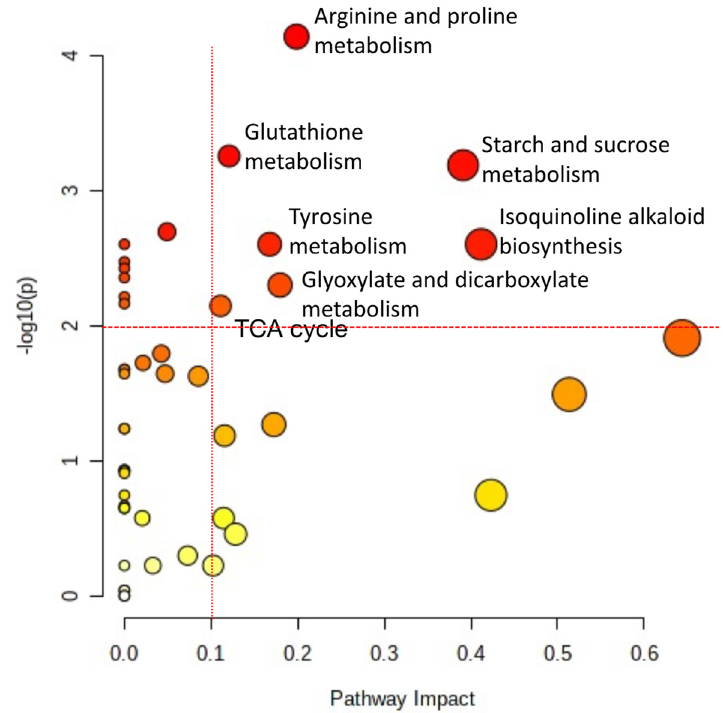
Figure 7. Significantly changed lettuce metabolism after 3 days of water, 1% and 2% horseradish water extract (HRE) treatments based on MetaboAnalyst pathway analysis. X-axis displays the pathway impact values that were estimated by topology analysis, and the circle sizes correspond to the pathway impact scores; Y-axis represents the -log(p) values that were calculated by over-representation analysis, and the circle colors correspond to p values (darker colors indicate more significant changes in metabolites in the corresponding pathway). The represented pathway names that were most significantly changed are characterized by both a high -log(p) value (>2) and high impact value (0.1).